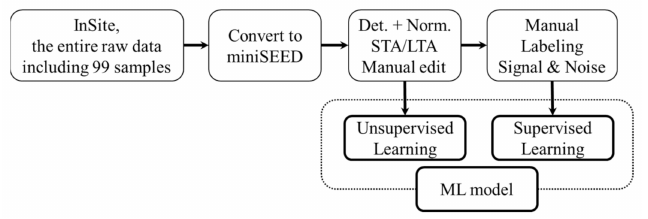
Figure 2. Pre-processing procedure of microseismic data for machine learning.